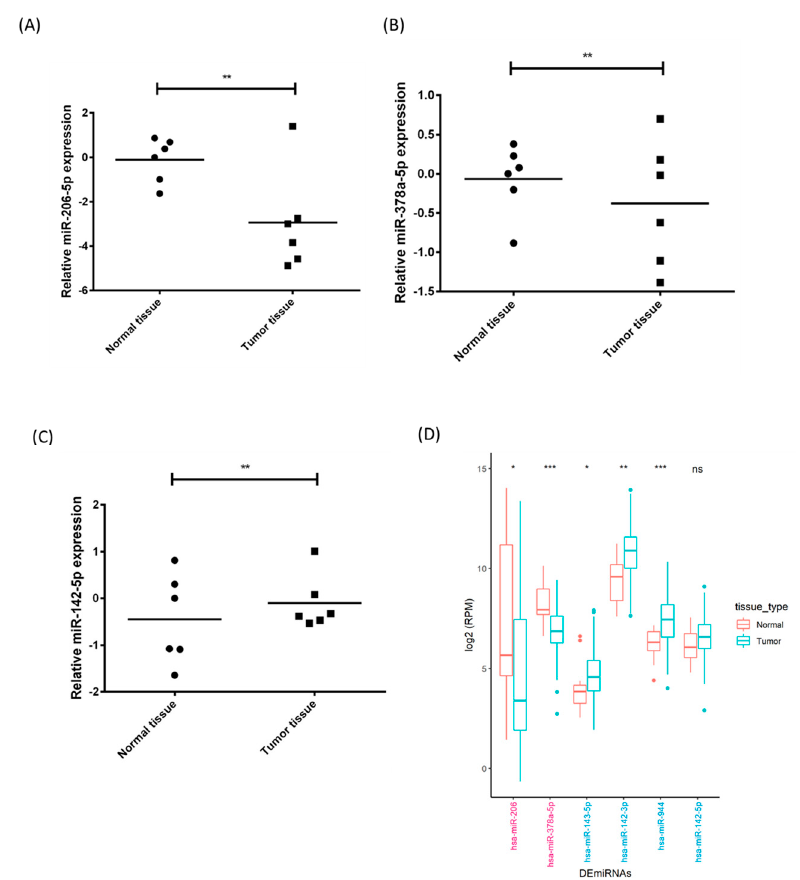
Figure 4. Comparison of the microRNA expression in clinical head and neck cancer (HNSCC) tissues and adjacent normal tissues by qPCR analysis. ( A ) MiR-206-3p. ( B ) MiR-378a-5p ( C ) MiR-142-5p. ( D ) Differentially expressed microRNA (DEmiRNA) in larynx tumor and normal tissues using the clinical information of The Cancer Genome Atlas (TCGA). *: p < 0.05, **: p < 0.01. ***: p < 0.001.